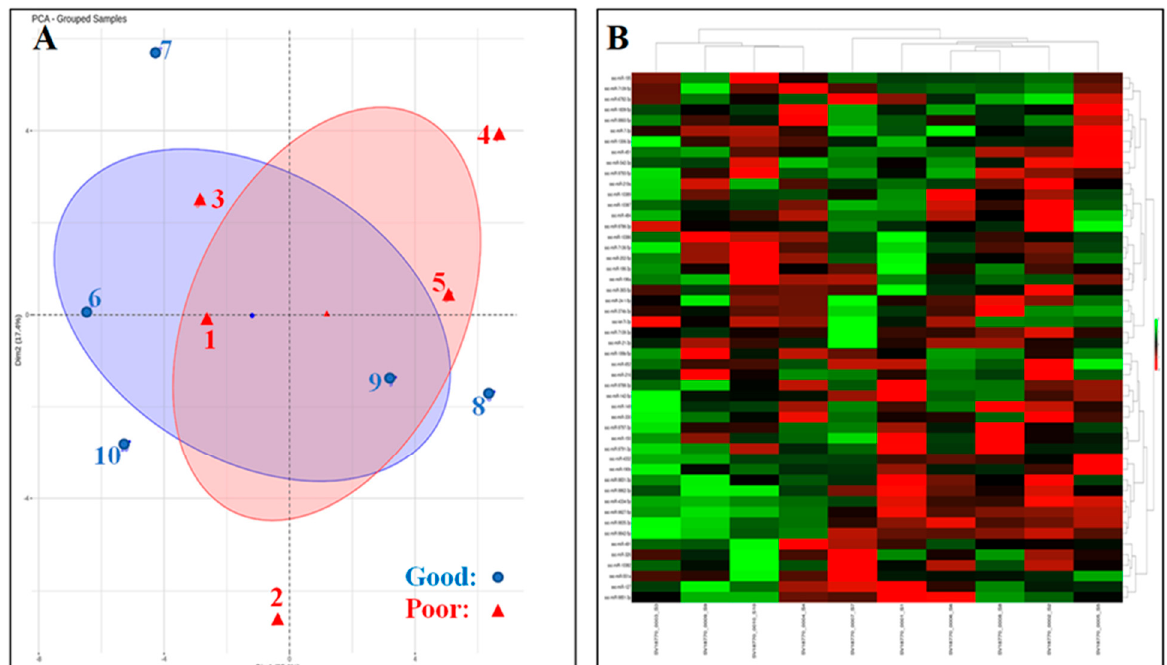
Figure 3. Principal component analysis (PCA) plot ( A ) and heat map with hierarchical clustering of miRNAs and samples ( B ). A total of 50 miRNAs having the highest %CV were used. The color code in the heat map indicates higher (green color) or lower (red color) miRNA expression relative to general mean expression. Five differentially expressed miRNA are found in this heat map (ssc-9828-3p,